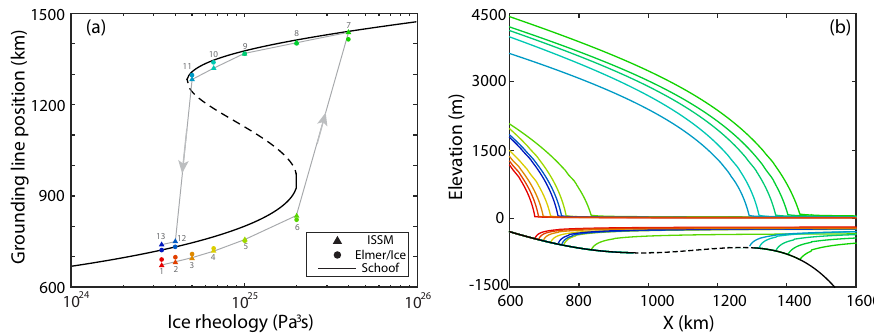
Figure 5. Results of MISMIP Exp. 3. (a) Steady-state grounding line positions of MISMIP Exp. 3. Triangles are results of ISSM; circles are results of the FS solution of Elmer/Ice Durand et al. (2009a) and the black curve is Schoof (2007) solution (Pattyn et al., 2012). The gray arrow shows the sequence of ice rheology perturbation at each step. (b) Steady-state profile at each step obtained by ISSM. The retrograde part of the bed is shown in dashed line.